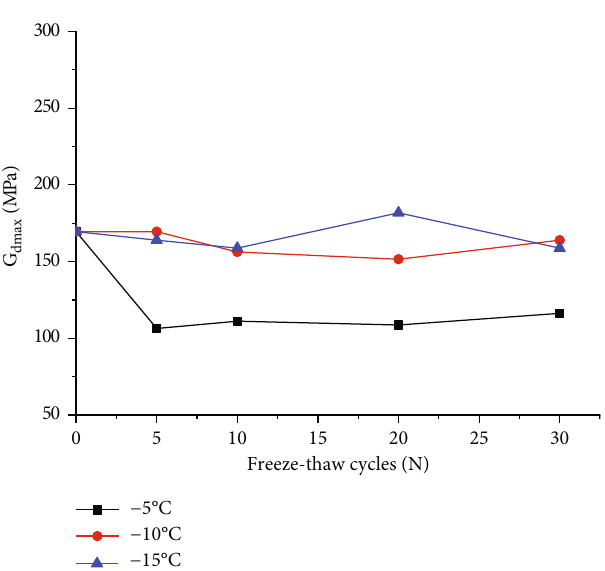
Figure 19: Curve of maximum dynamic shear modulus and freeze- thaw cycles at di ff erent freezing temperatures.